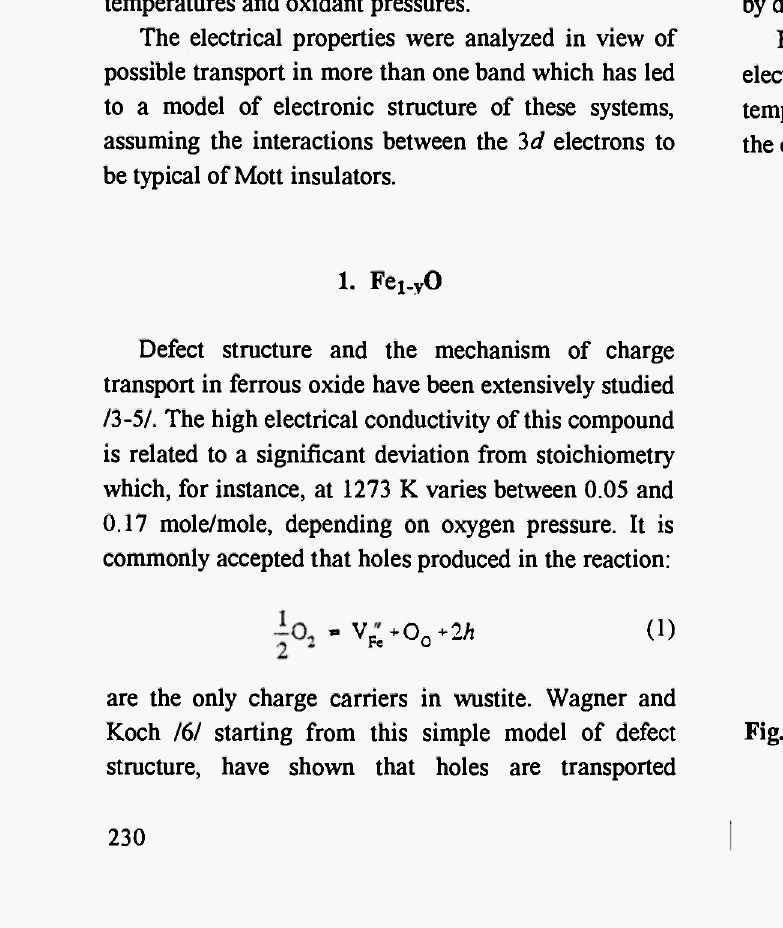
Electrical conductivity vs. oxygen pressure for ferrous oxide at different